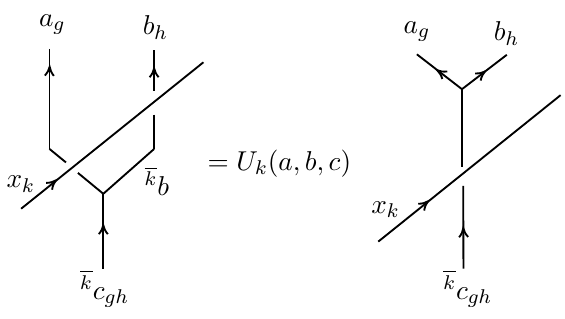
Figure 7 . Diagrammatic definition of U k ( a, b, c ) .